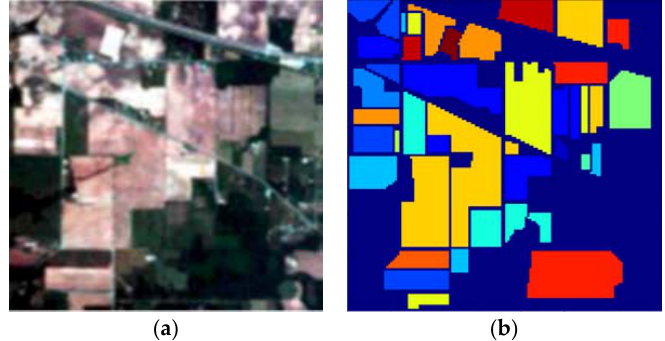
Figure 4. Indian Pines data set. ( a ) False-color image of the Indian Pines data. ( b ) Ground-truth map of the Indian Pines.